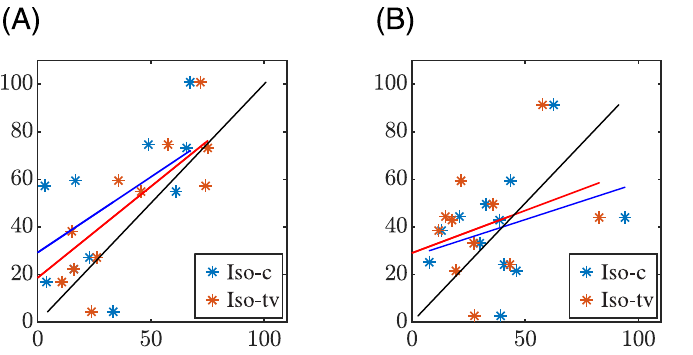
Fig 7. Relationship between the QT adaptation delays calculated using the U estimation strategy in patients (vertical axis, τ , φ 2 { e , r }) and in simulations (horizontal axis, τ ) for a constant (blue) or time-varying Iso φ , p φ , s level (red). Fitted lines are shown in the corresponding colors, while black lines show the diagonal. The left panel corresponds to the exercise phase and the right panel to the recovery